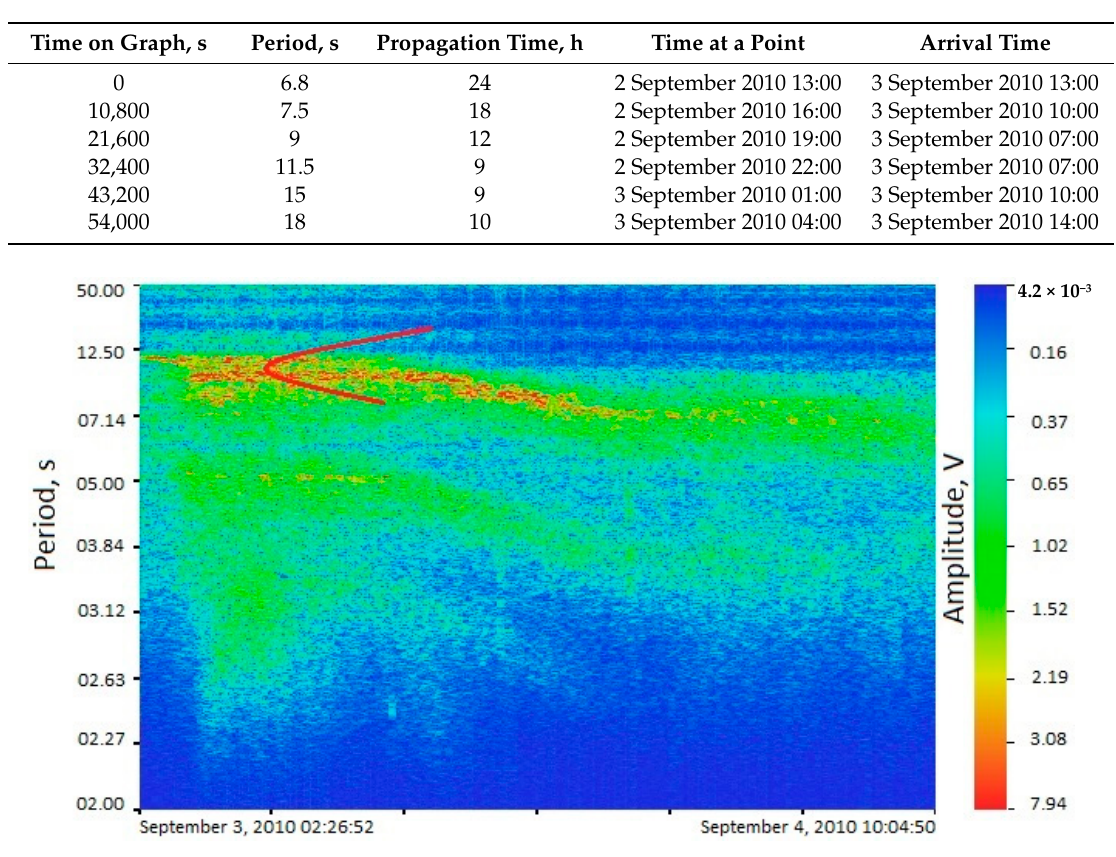
Figure 8. Graph of the swell period change on the typhoon speed and the angle of direction to the receiver (left scale, red curve), change in the typhoon wind speed (right scale, blue curve).